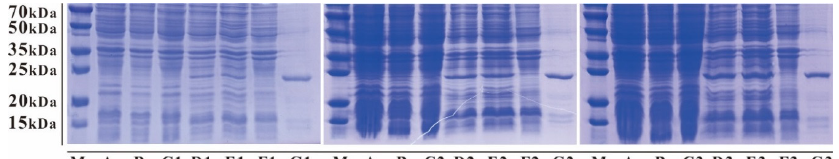
Figure 3. SDS-PAGE analysis of the recombinant mNKLs. Recombinant vectors pET32-mNKLs and pET-32a(+) were transformed into E. coli Rosetta (DE3) and induced by 0.1 mM IPTG for 4 h at 37 ◦ C. Induced bacterial cells including pET32-mNKLs were disrupted by ultrasonication, and the supernatant and precipitation were separated by centrifugation. The recombinant mNKLs was purified by affinity column chromatography. All the samples were analyzed by SDS-PAGE, and the protein was stained with Coomassie Blue R250 in the gel. M, molecular mass marker in kDa; Lane A – B , the E. coli Rosetta (DE3) including pET-32a(+) were not induced and induced, respectively; lane C , the E. coli Rosetta (DE3) including pET32-mNKLs were not induced; lane D , the full bacteria lysates of E. coli Rosetta (DE3) including pET32-mNKLs were induced; lane E – F , the supernatant and precipitation of the E. coli Rosetta (DE3) including pET32-mNKLs were induced; lane G , purified mNKLs. 1 , 2 and 3 represented mNKL 1, mNKL 2 and mNKL 3,